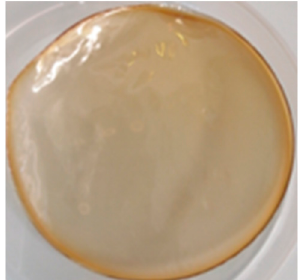
Figure 4. Image of a cast graft copolymer fi lm.